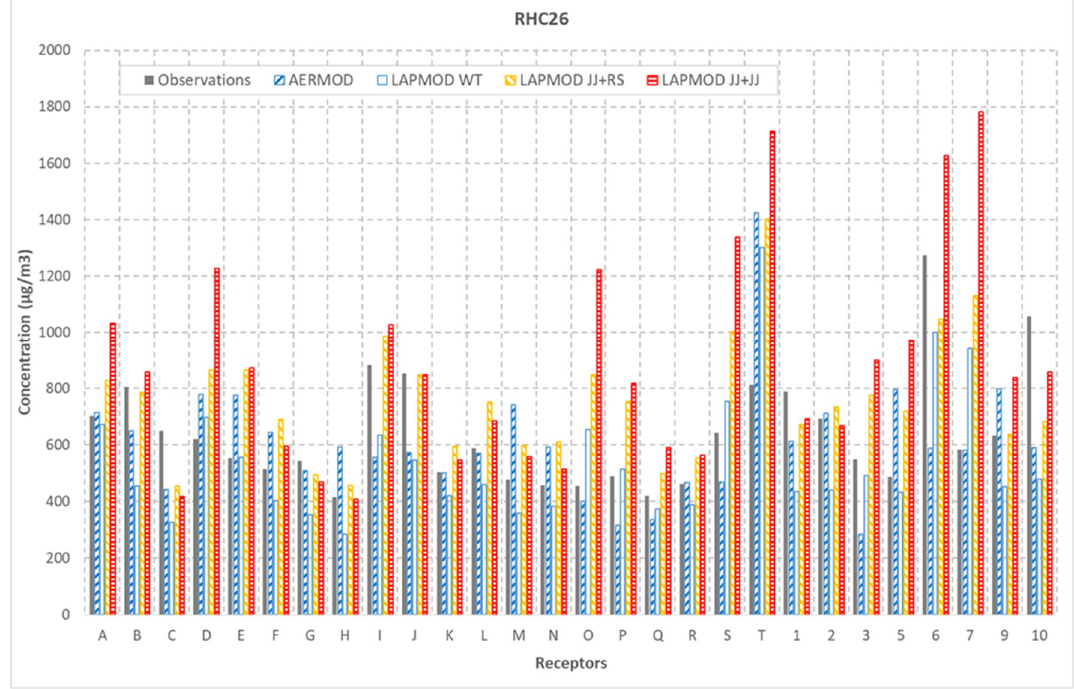
Figure 11 . RHC 26 concentrations for observations, AERMOD, and LAPMOD predictions.